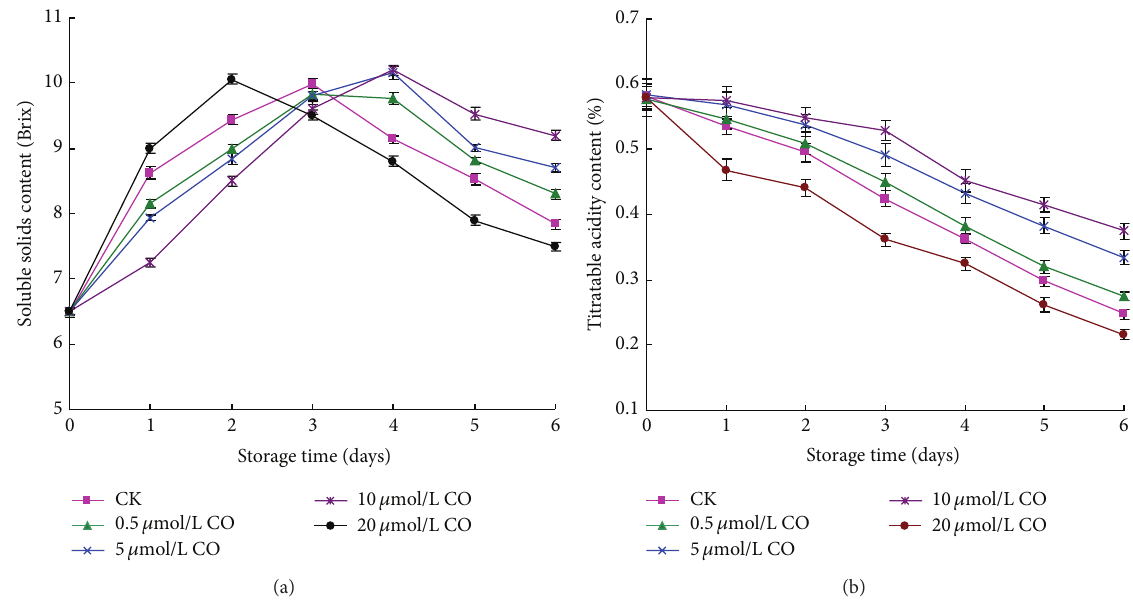
Figure 2: Effect of CO fumigation on soluble solids content (a) and titratable acid (b) of postharvest peaches. Each point represents the mean value ±